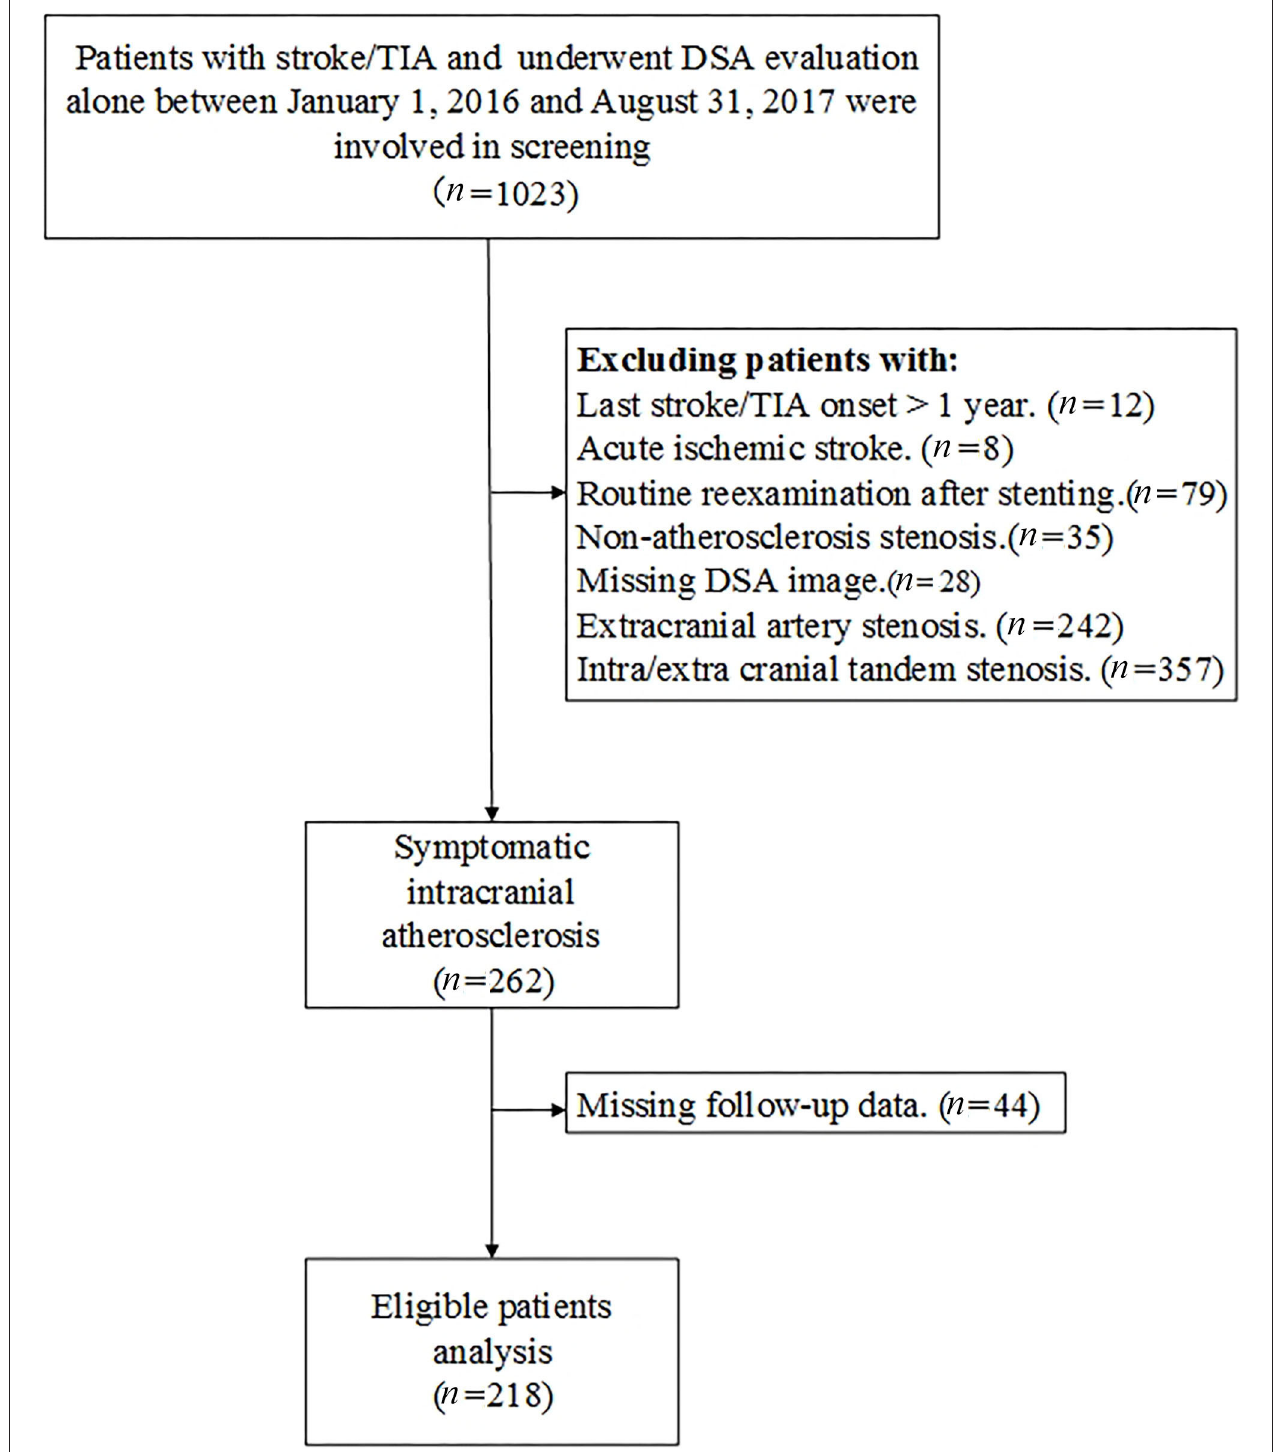
FIGURE 1 | Flow chart of patient screening for the study.